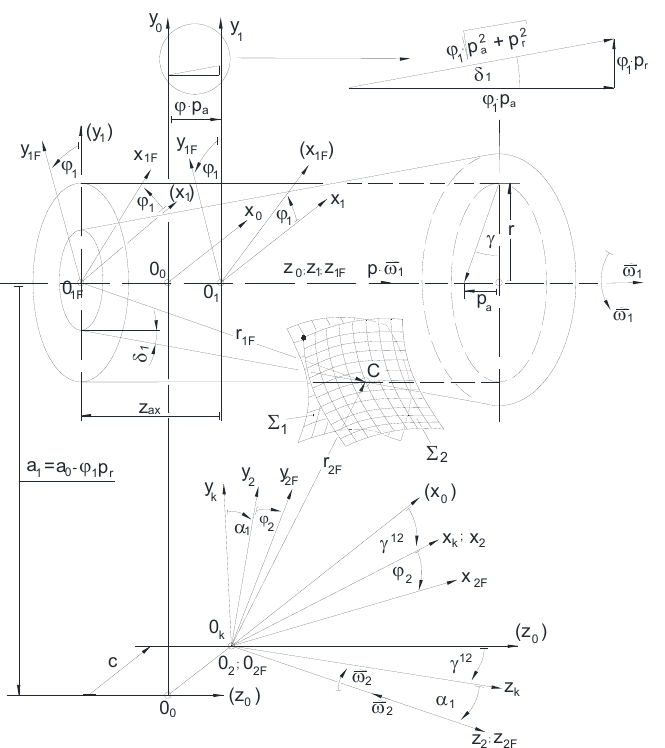
Figure 1. The frames defined for the analysis of the production geometry of the surface Σ 1 of the worm and the Σ 2 of the wheel, based on [18].